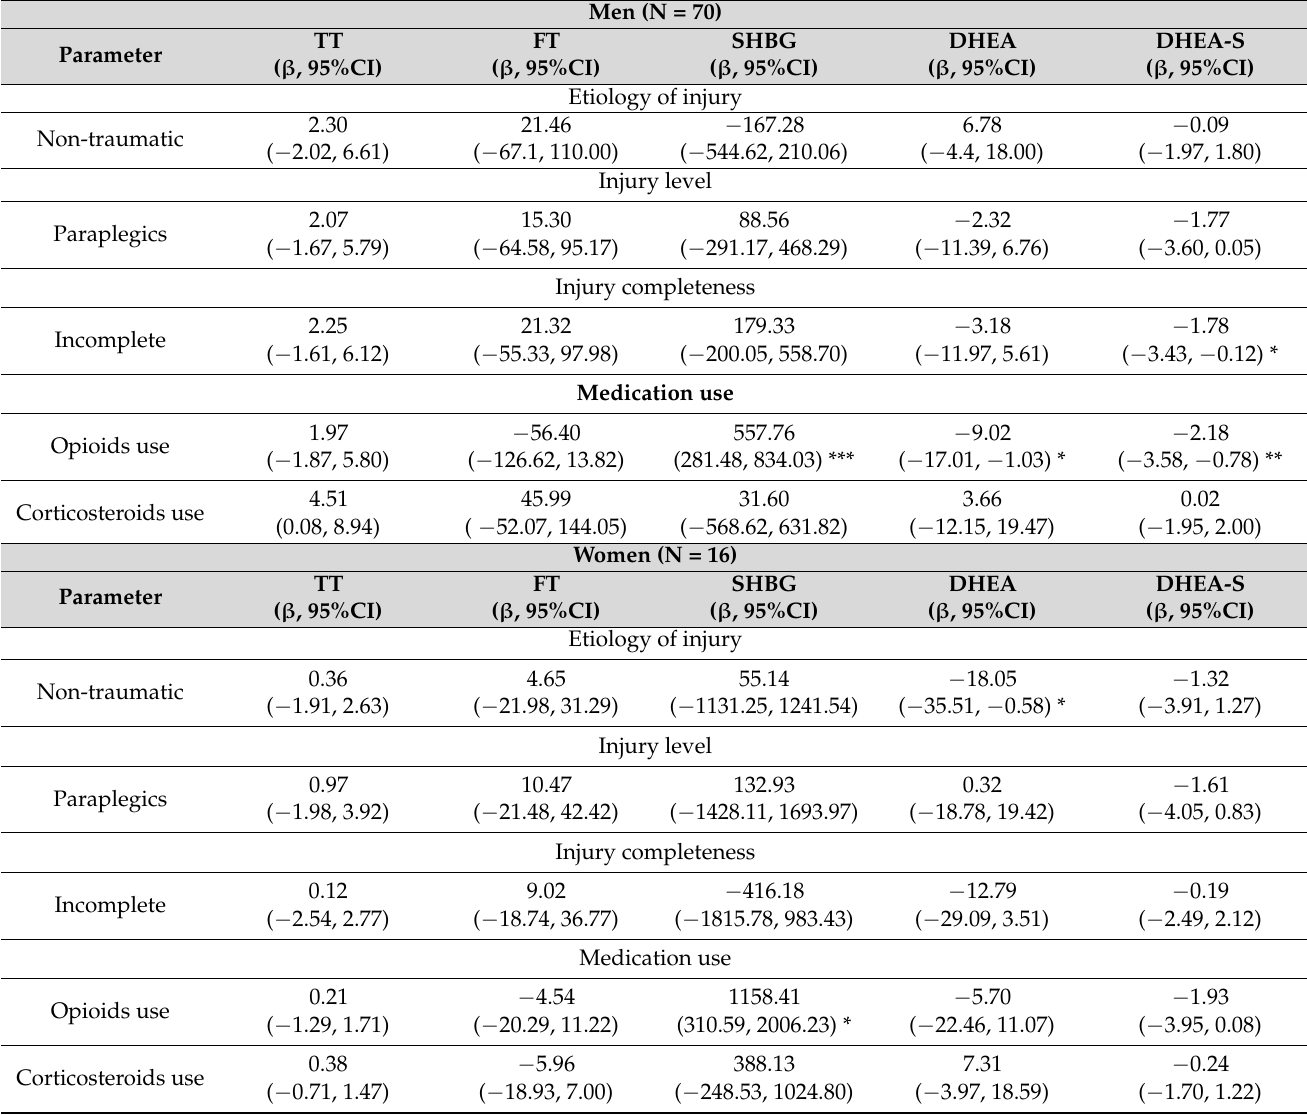
Table 2. Association between individual patient and injury’s characteristics and hormone levels at baseline (beginning of rehabilitation).